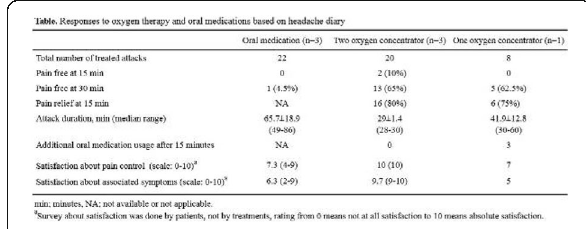
Fig. 1 (abstract P0409). See text for